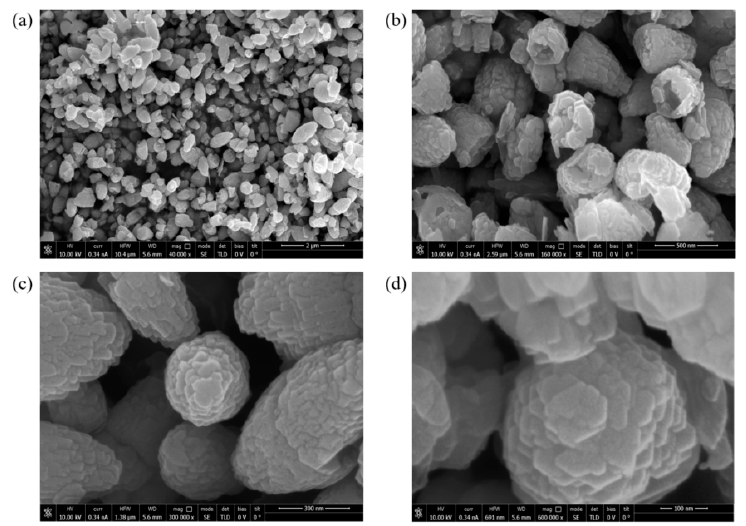
Figure 7. SEM images of the ZnO NPs at different magnifications; 40,000× ( a ), 160,000× ( b ), 300,000× ( c ) and 600,000× ( d ).